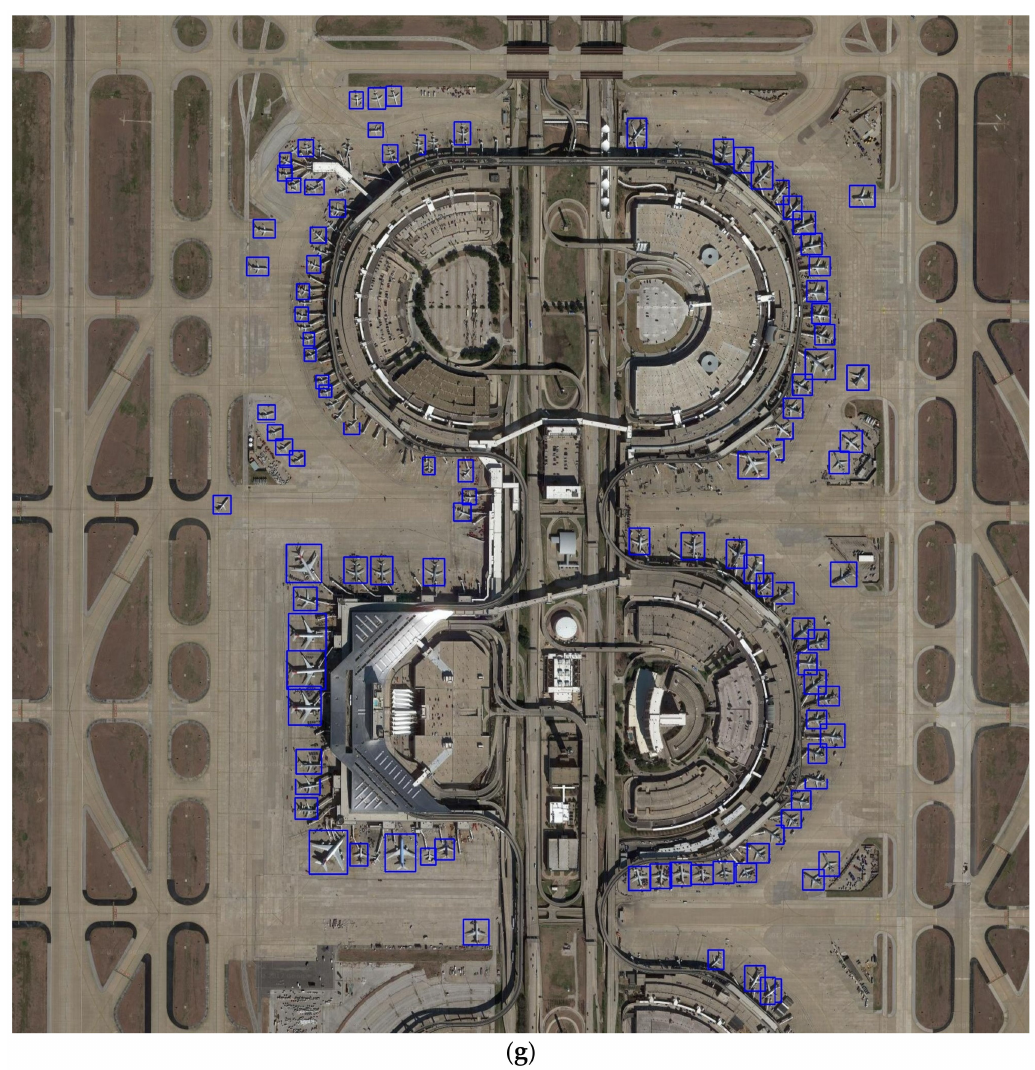
Figure 9. The results of airplane detection. ( a – f ) are detection results of different small input images; and ( g ) is a large image; it is clearly seen that the small objects are detected